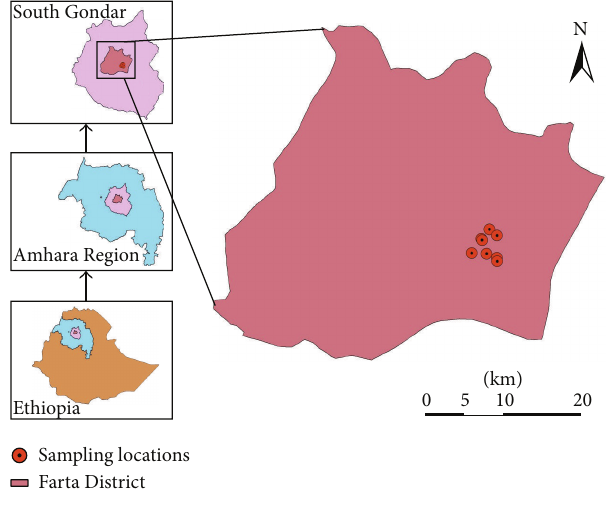
Figure 1: Location map of the study